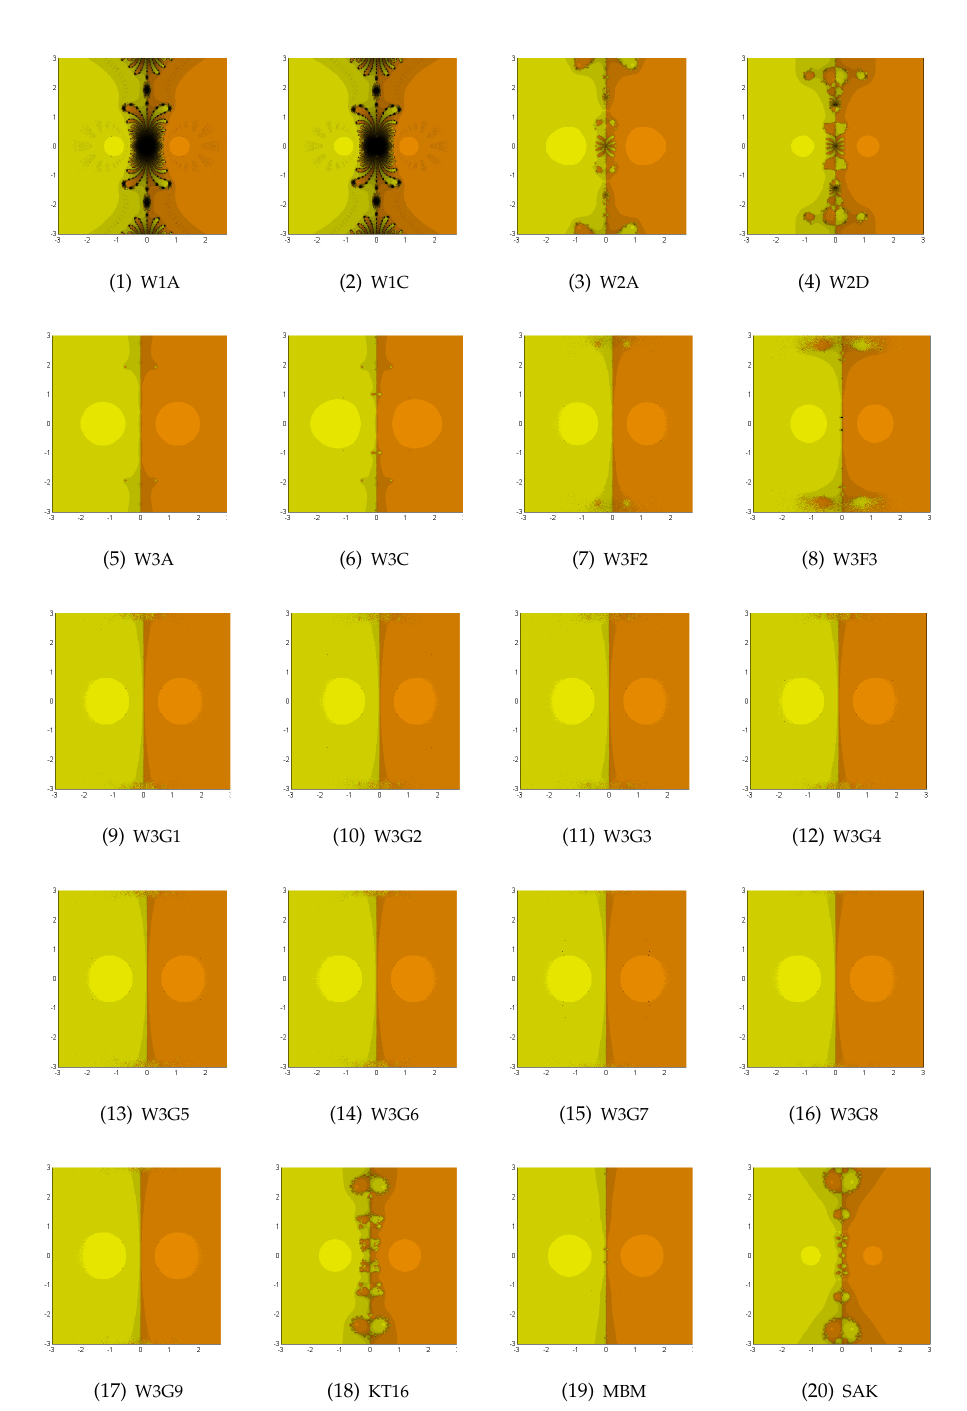
Figure 1. The top row for W1A (left), W1C (center left), W2A (center right) and W2D (right). The second row for W3A (left), W3C (center left), W3F2 (center right) and W3F3 (right). The third row for W3G1 (left), W3G2 (center left), W3G3 (center right), and W3G4 (right). The fourth row for W3G5 (left), W3G6 (center left), W3G7 (center right), and W3G8 (right). The bottom row for W3G9 (left), KT16 (center left), MBM (center right) and SAK (right), for the roots of the polynomial equation ( z 2 − 1